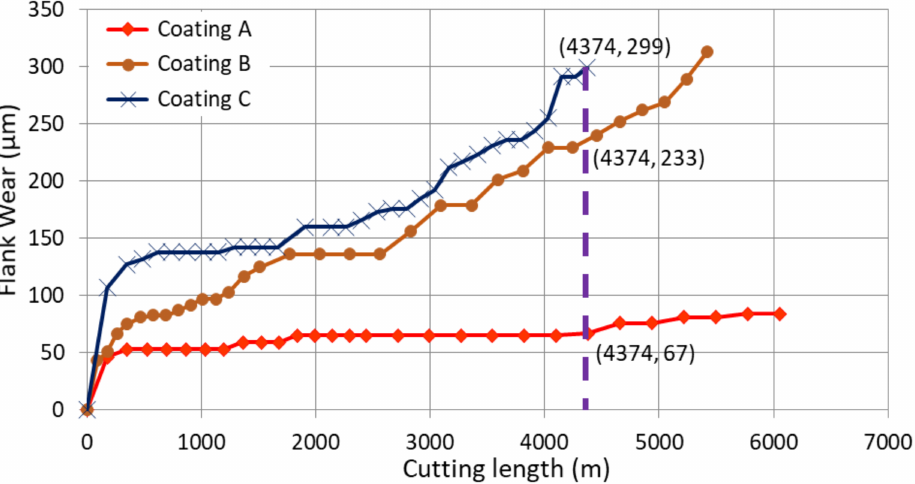
Figure 1. Flank wear vs. cutting length data for the three TiB 2 coatings during wet rough turning of Ti6Al4V